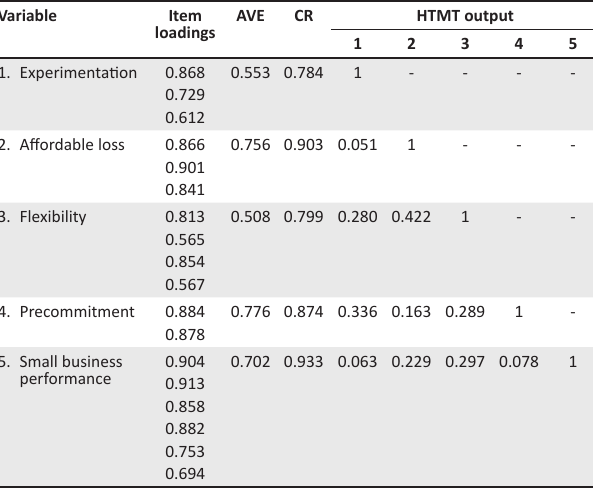
TABLE 2: Outcome of construct validity